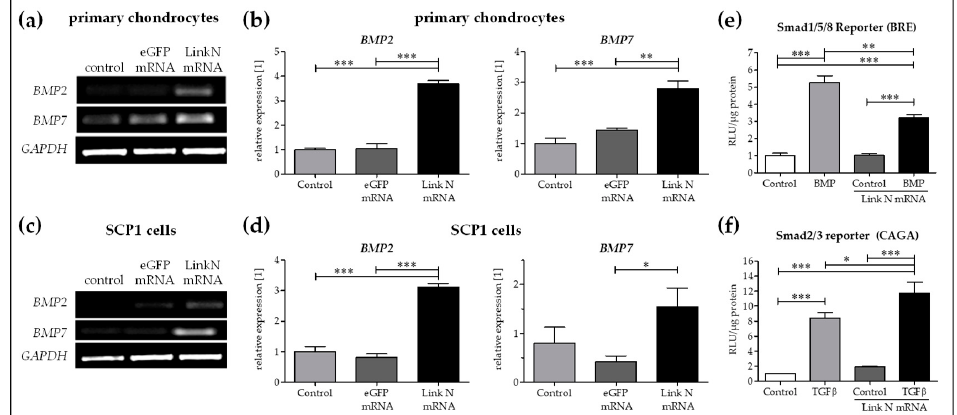
Figure 6. The influence of Link N mRNA delivery into primary chondrocytes and SCP1 cells on BMP2 and BMP7 gene expression. Primary chondrocytes and SCP1 cells (1 × 10 5 ) were transfected with 1 µg of Link N mRNA, and the influence on BMP2 and BMP7 expression was examined 24 h after Link N mRNA transfection, using semi-quantitative RT-PCR. Cells treated with Lipofectamine 2000 and eGFP mRNA transfected cells were used as controls. GAPDH was used as an internal control and served to normalize the expression. ( a , c ) Representative gel images to evaluate the changes in BMP2 and BMP7 gene expression, 24 h after Link N mRNA transfection. ( b , d ) Relative expression levels obtained by densitometric analysis. Link N mRNA transfected SCP1 cells infected with ( e ) Ad5-BRE-Luc reporter construct (smad1/5/8 reporter) and stimulated with 50 ng/mL rhBMP 2 or with ( f ) Ad5-CAGA9-MLP-Luc reporter construct (smad2/3 reporter) and stimulated with 10 ng/mL rhTGF β 1. After 24 h, luciferase activity was measured in cell lysates and normalized to total protein content. Data are represented as mean ± SEM (N = 3) and were compared using one-way ANOVA with Bonferroni’s multiple comparison test. *** p < 0.001, ** p < 0.01, * p < 0.05 as indicated.